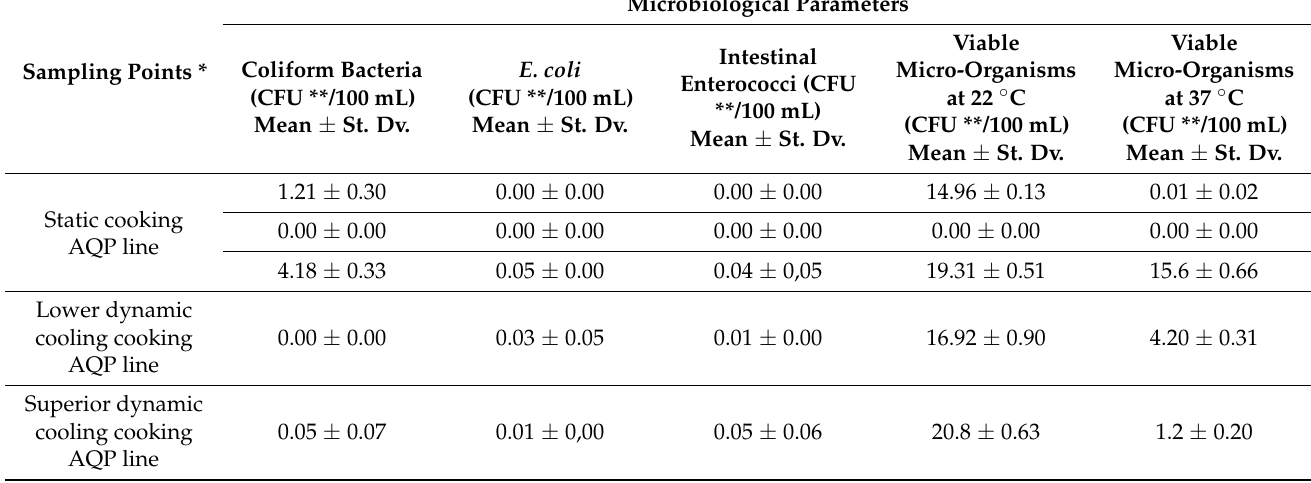
Table 5. Results of the average calculation for each microbiological parameter of the 48 water samples * from the sampling point monitoring in Case Study 2. Limits and methods of analysis specified by Lgs.D. 31/01 [18] on the quality of water intended for human consumption. * The samples were collected in two seasonal sampling campaigns carried out in April and October on all points of the monitoring network. ** CFU: colony-forming